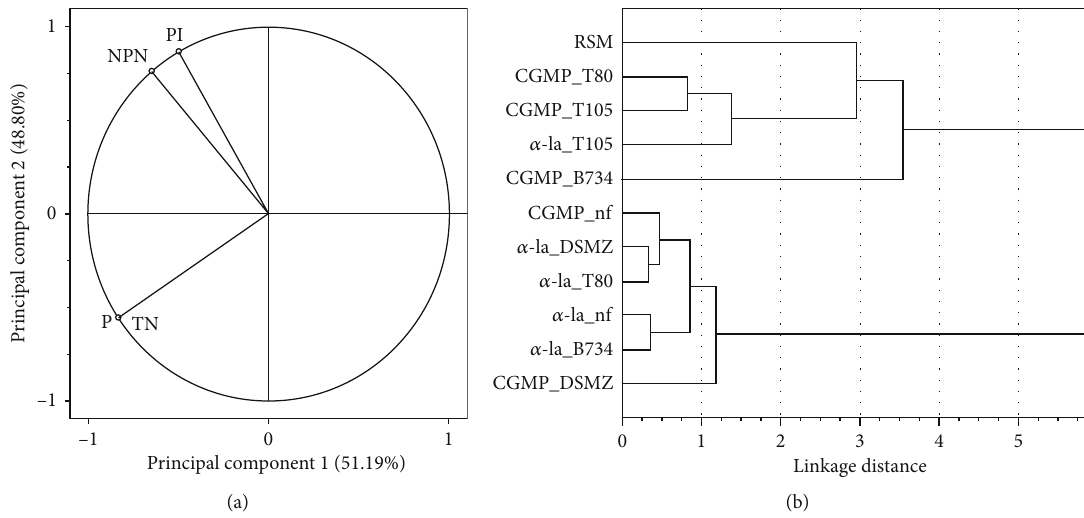
Figure 2: Projection of variables on the principal component plane (a) and dendrogram expressing the results of hierarchical cluster analyses of similarities of products in terms of the proteolysis index and contents of protein, total nitrogen, and non-protein nitrogen